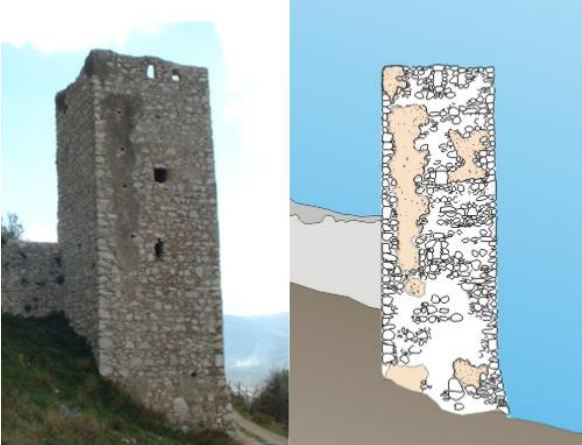
Figure 5-6: The south-western corner tower of the outer walled line front and its building techniques (PIT,